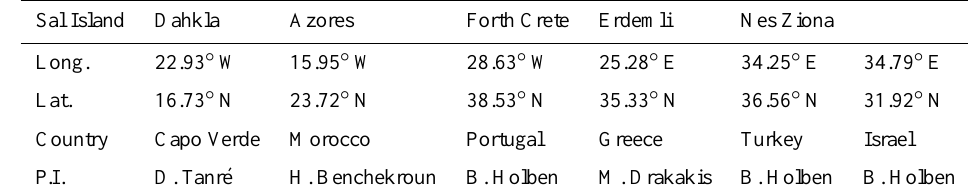
Table 2. AERONET stations available in June 2003 to validate MSG aerosol retrievals. Sal Island